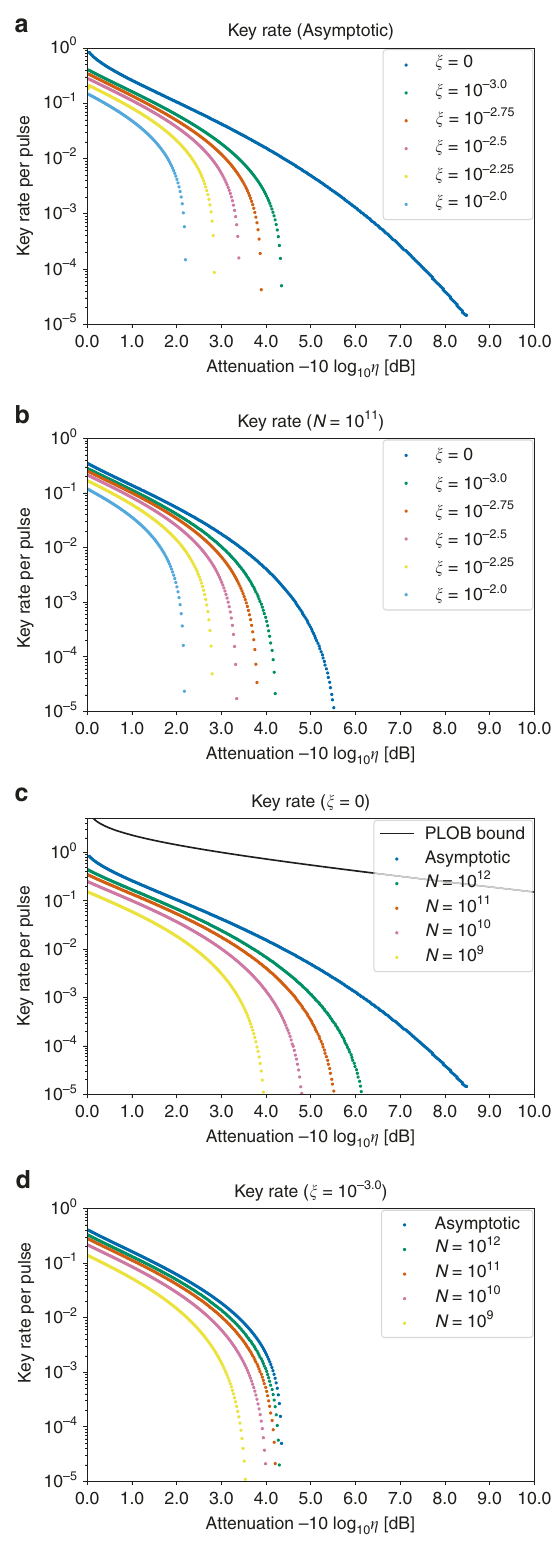
measurement used for the test in the protocol, assume that a digitized outcome ω dig ensures that the true value ^ ω lies in a range Ω ( ω dig ). Then, we need only to replace Λ its worst-case value, min f Λ